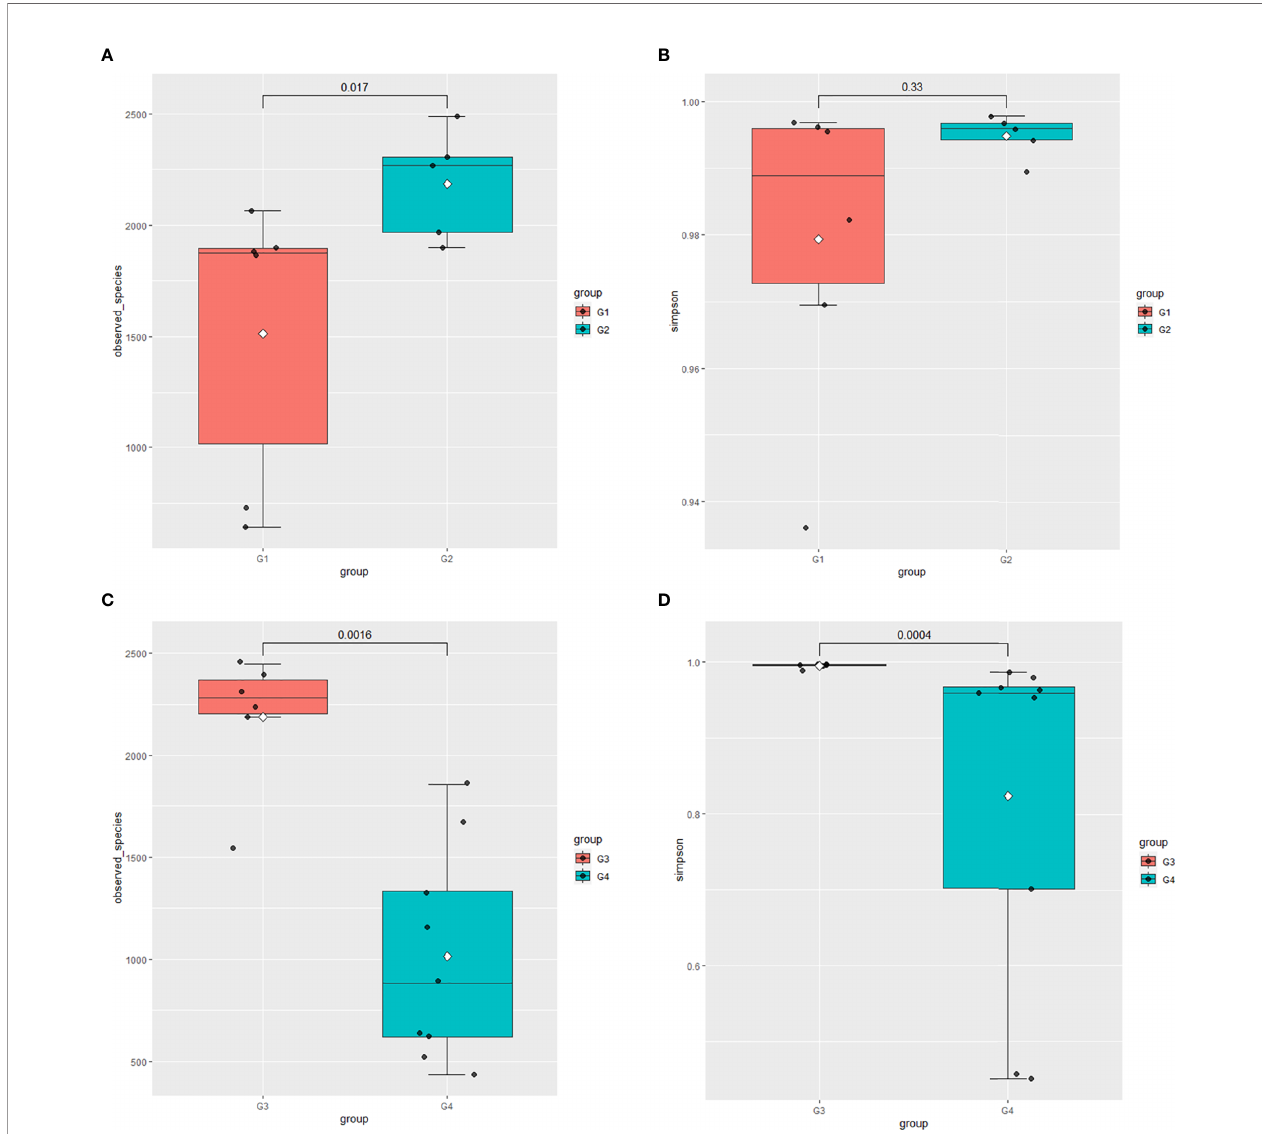
FIGURE 5 | Microbial alpha diversity of urine samples. (A) Observed species in healthy men; (B) Simpson Index in healthy men; (C) Observed species in men with BC; (D) Simpson Index in men with